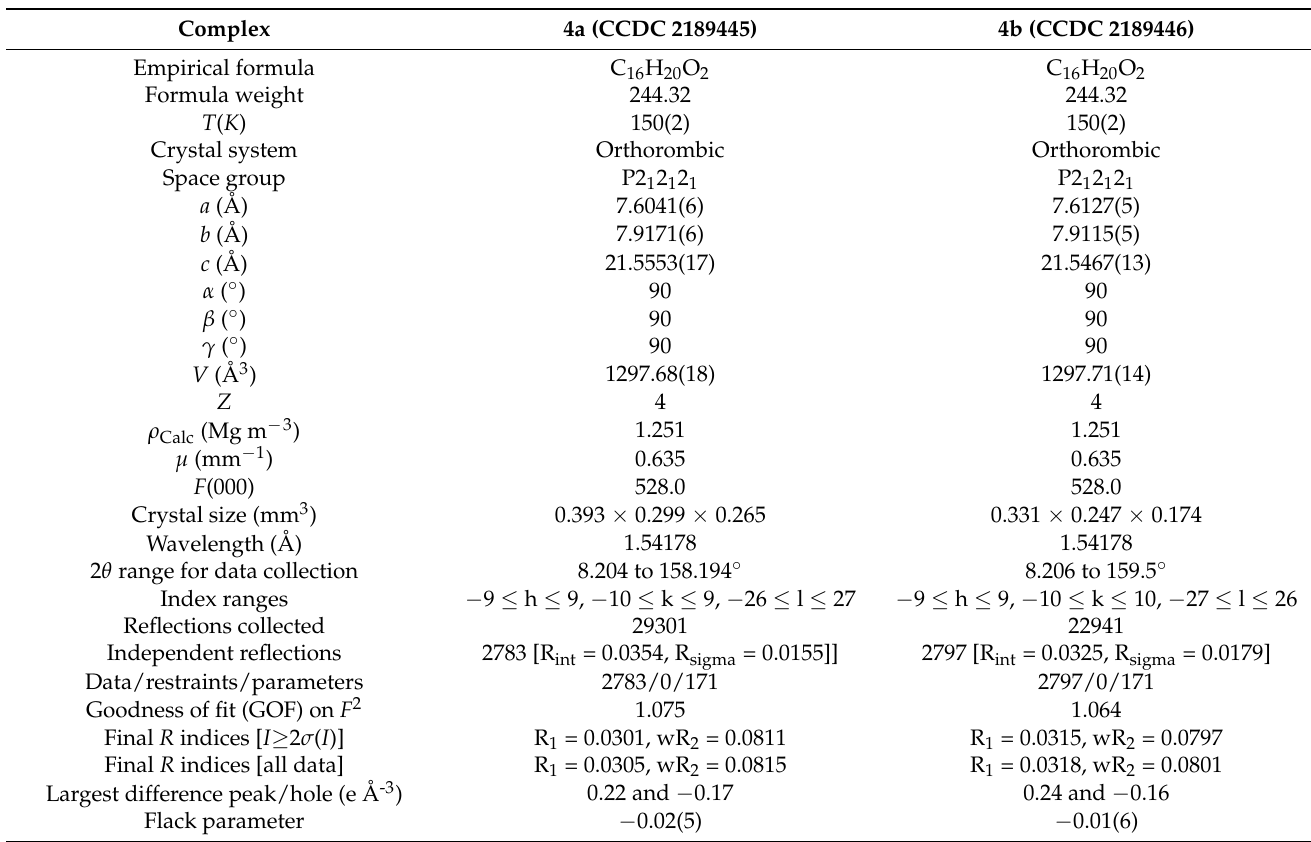
Figure 2. Crystal structure of compounds 4a ( left ) and 4b ( right ). Displacement ellipsoids are drawn at a 50% probability level. The intramolecular interactions are shown as dashed red lines. Table 1. Crystallographic data of compounds 4a and 4b .